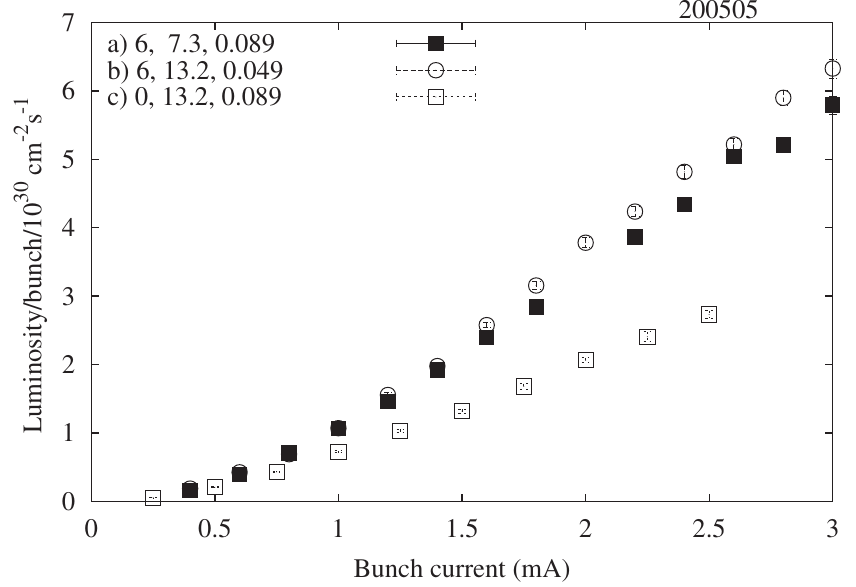
(cid:1) 0 : 089 and (cid:3) (cid:1) s l (cid:1) 0 , 56